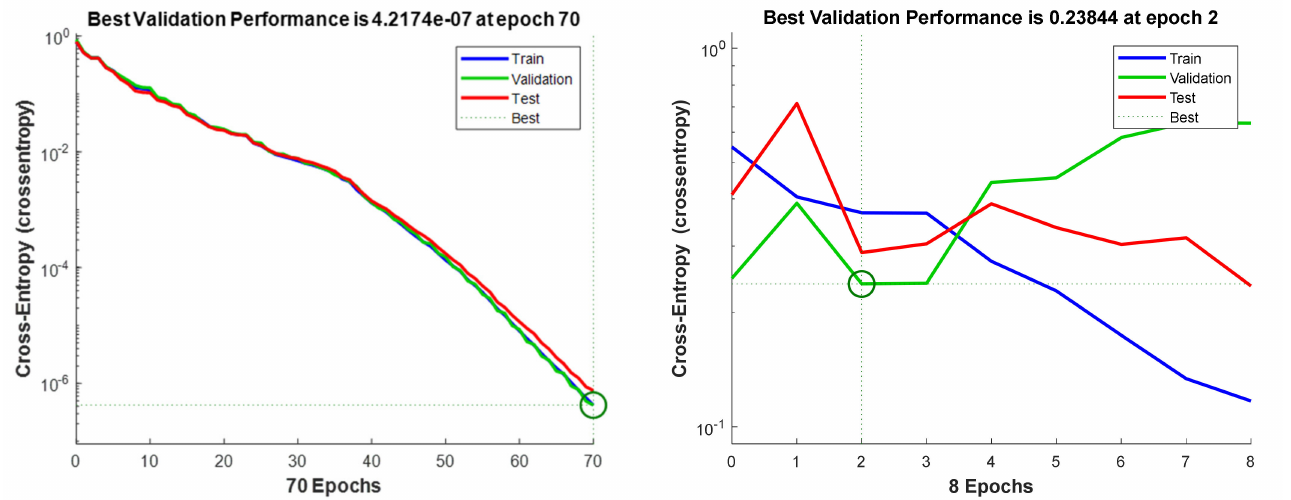
Figure 8. Neural network convergence for Tensile Strength ( left ) with self-growing and ( right ) without